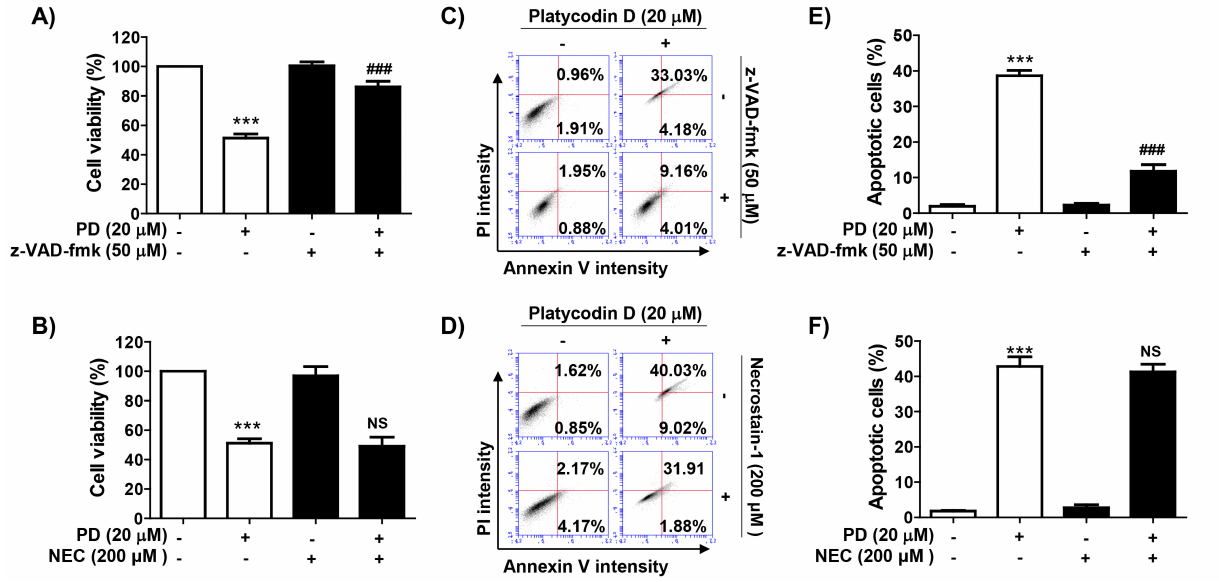
Fig. 3. The effects of caspase and necroptosis inhibitors on PD-mediated growth reduction and apoptosis in PC3 cells. The cells were pre-treated with 50 µ M z-VAD-fmk, a pan-caspase inhibitor, or 200 µ M necrostain-1 (NEC), a necroptosis inhibitor, for 1 h, and maintained in the presence or absence of 20 µ M PD for 48 h. (A,B) Cell viability was measured by the MTT assay. (C–F) The fixed cells were stained with annexin V/PI for flow cytometry analysis. (C,D) Representative flow cytometry plots are presented. (E,F) The populations of apoptotic cells were determined by expressing the numbers of annexin V + cells. The data are presented as the mean ± SD of three independent experiments ( ∗∗∗ P < 0.001 compared to control; ### P < 0.001 compared to PD-treated cells; NS, not significant compared to PD-treated